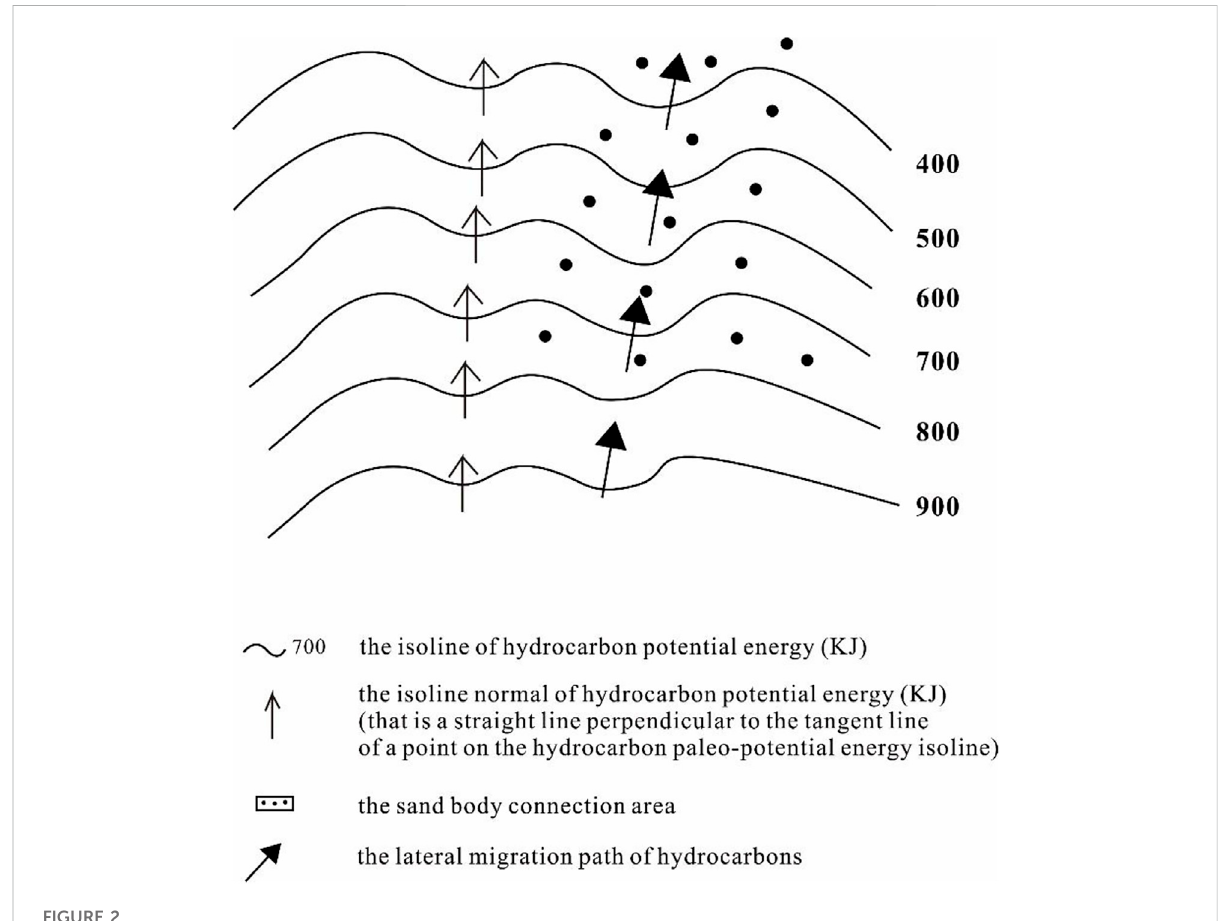
Schematic determining the lateral migration path of hydrocarbons in a slope